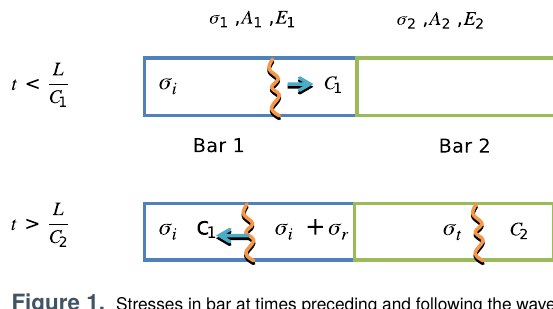
Figure 1. Stresses in bar at times preceding and following the wave front crossing the interface (the incident, reflected and transmitted components of stress are denoted by sub- scripts i,r,t respectively).